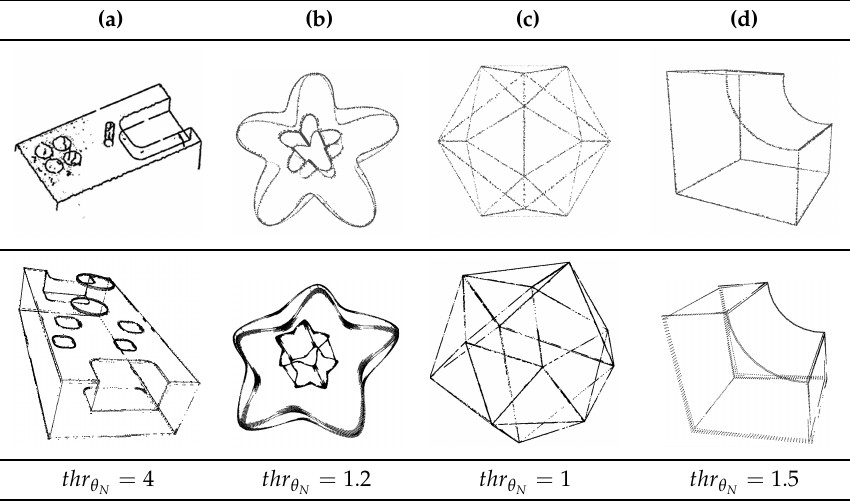
Table 3. The comparison of the testing results (upper row: model from [18,47]), bottom row: edge detection with the incremental change of the threshold value).